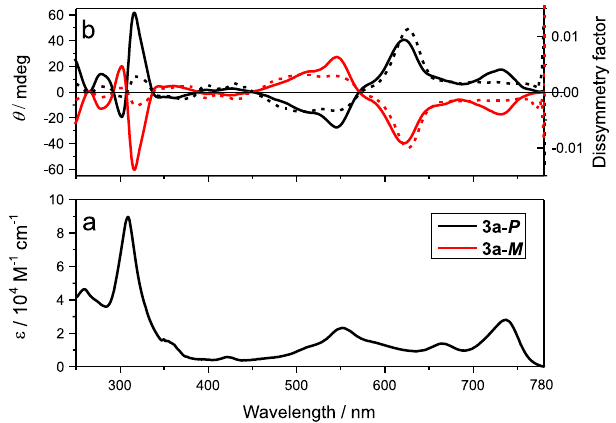
Fig. 2 Photophysical property characterization. a Absorption and b CD spectrum/dissymmetry factor ( g abs ) of 3a (10 μ M in chloroform, solid line: CD, dashed line: g abs